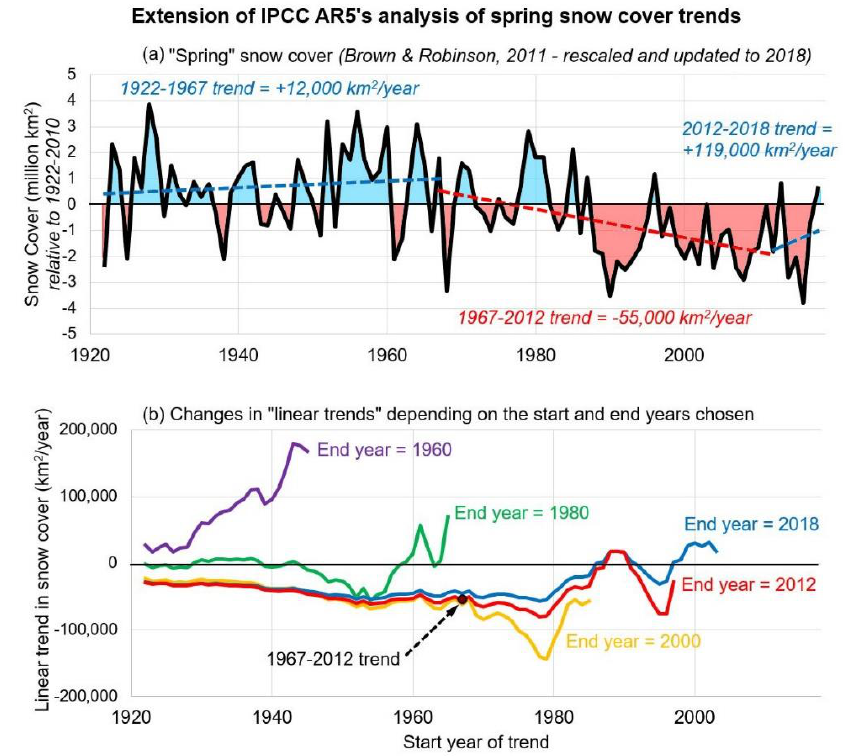
Figure 10. ( a ) Comparison of the 1967–2012 linear trend in Northern Hemisphere spring snow cover extent (red dashed line) discussed by the IPCC AR5 Working Group 1 report with the trends before and after that period (blue dashed lines). ( b ) How the “linear trend” changes depending on the start and end years of the time period chosen.